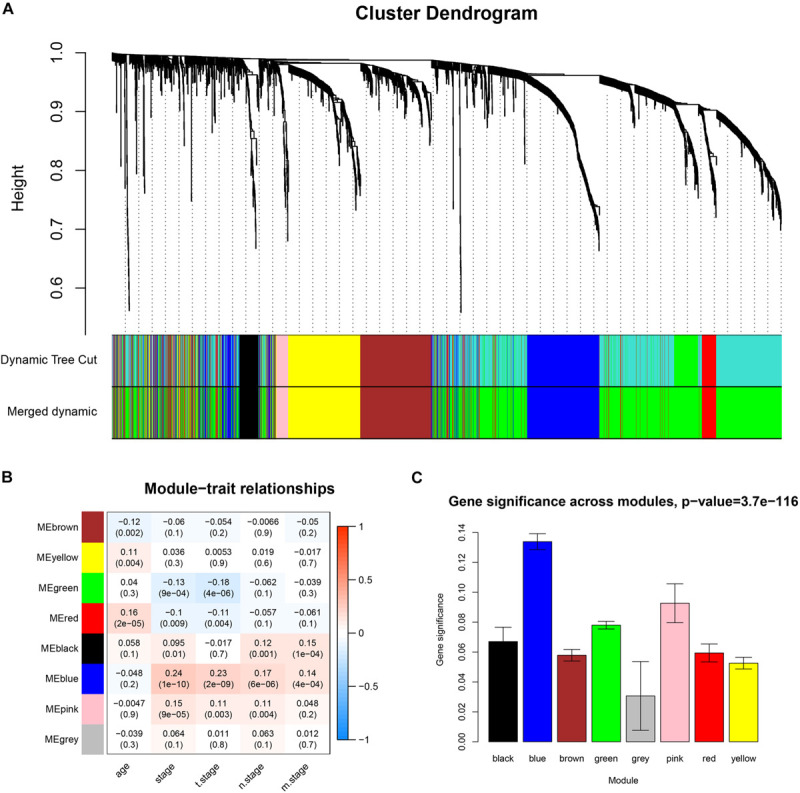
Identifying co-expressed modules and the correlation between modules and the clinical features. (A) Dendrogram of all DEGs clustered based on a dissimilarity measure (1-TOM). (B) Correlation heatmap showed the correlation coefficients between gene modules and clinical features of BC. (C) The bar plot showed the distribution of average gene significance at different modules.